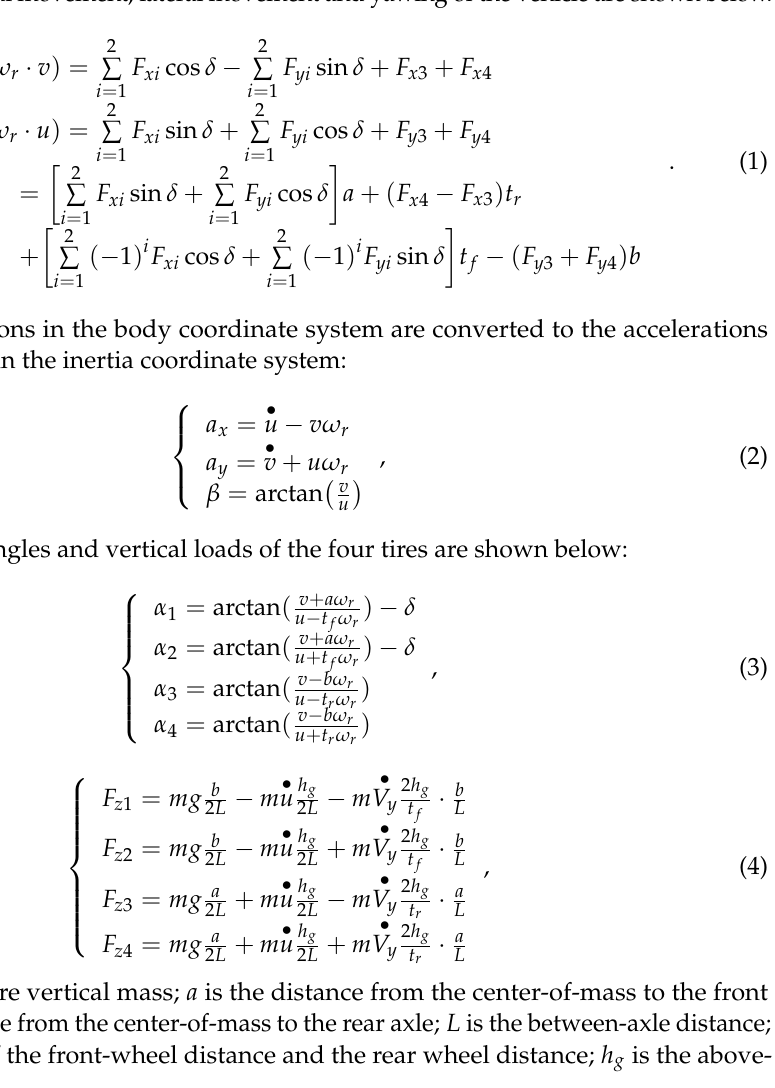
Figure 2. Seven-degrees-of-freedom vehicle dynamic model. The longitudinal movement, lateral movement and yawing of the vehicle are shown